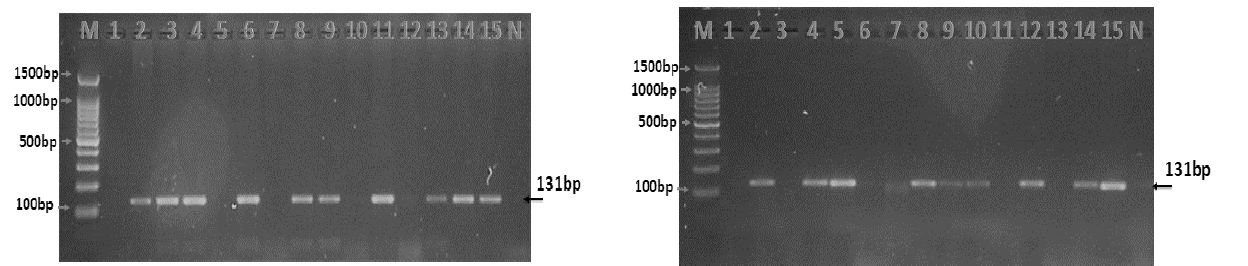
Figure 1. Agarose gel (1%) electrophoresis image shows the nested-PCR product analysis of the B1 gene of Toxoplasma gondii from aborted women blood samples. M: marker (1500-100 bp), Lanes (1-15)